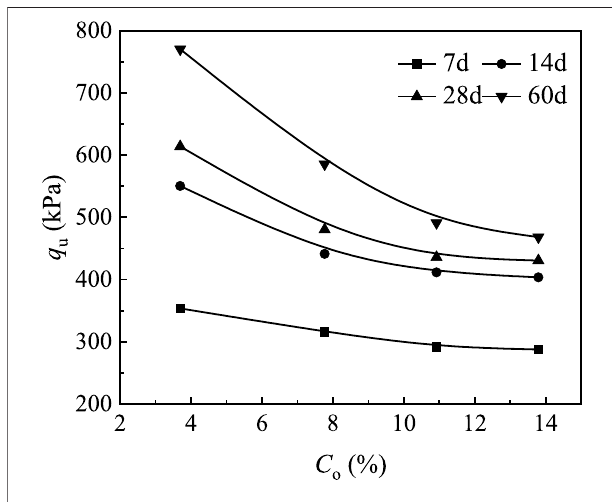
FIGURE 1 | Strength q u plotted with respect to organic matter content C o